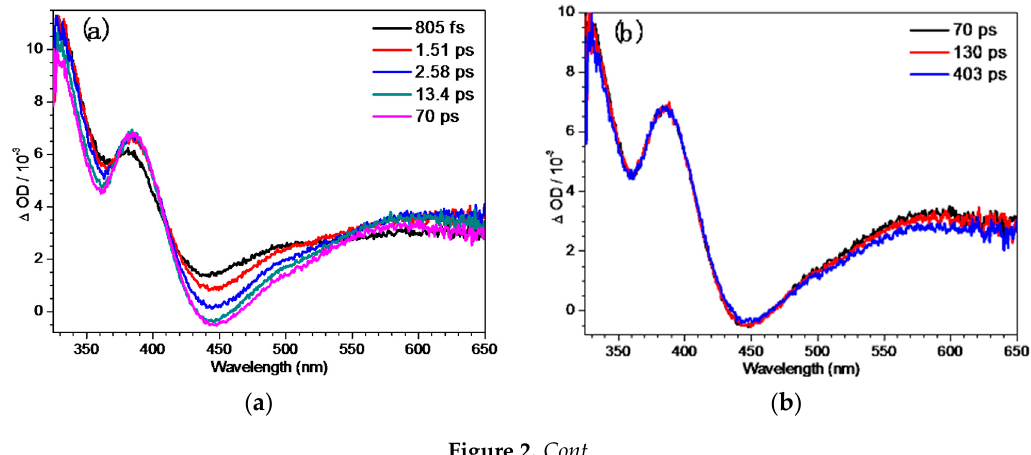
Figure 4. ( a ) UV-Vis spectra of BQMP-b in mixed solution with different pH values. ( b ) UV-Vis spectrum (top) and the BQMP-b calculated TD-B3LYP/6-311G(d,p) electronic spectrum of deprotonated species (middle and bottom).